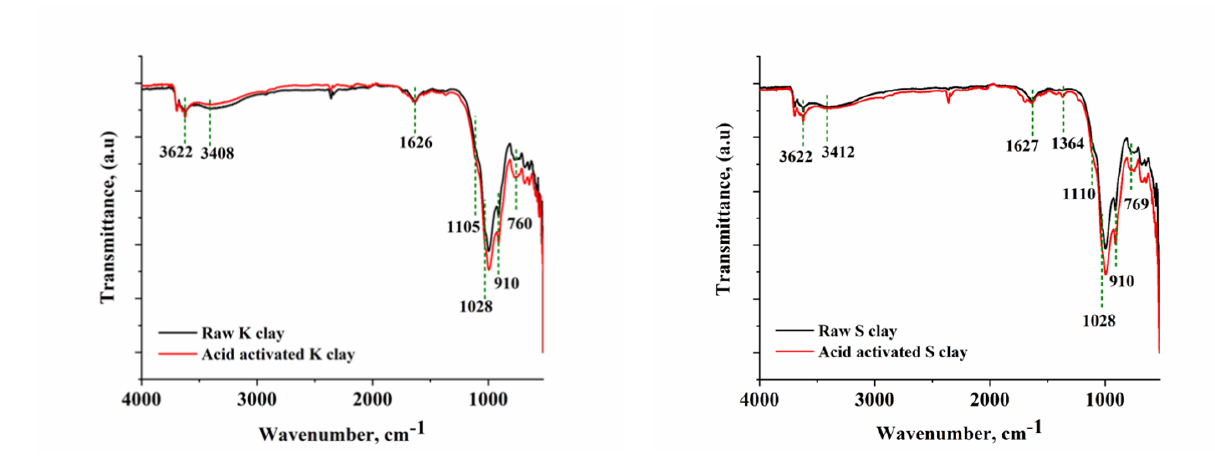
Figure 1: FT-IR spectra of raw and acid-activated Kommathurai (K) clay.